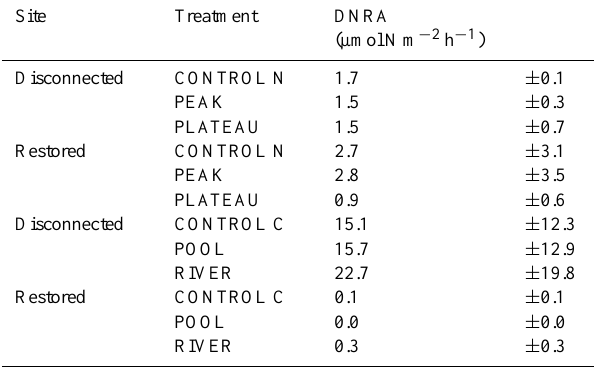
Table 2. Mean DNRA rates ( n = 3) measured and standard devia- tion in the sediment after five-day incubation.